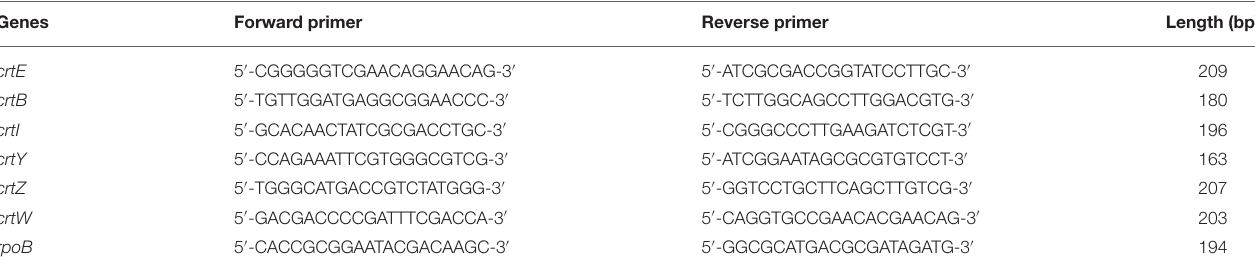
TABLE 1 | Primer sequences for the real-time quantitative polymerase chain reaction.